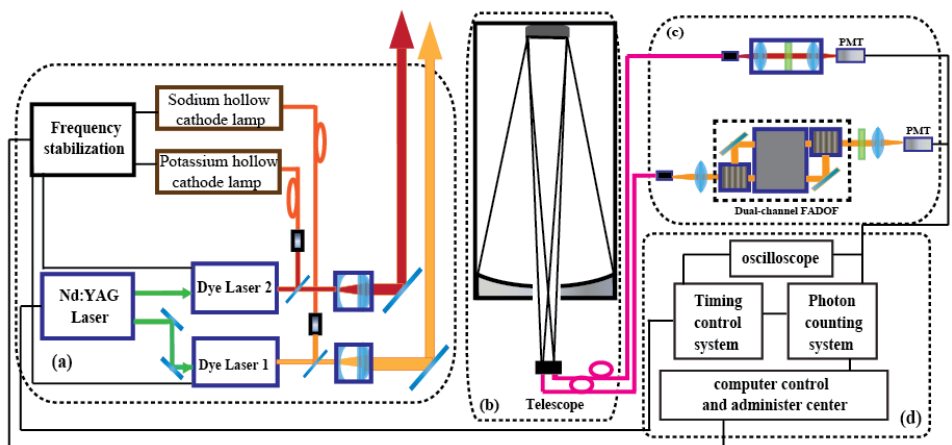
Figure 1. Schematic diagram of diurnal sodium fluorescence lidar system (dual-wavelength lidar detection system). A lidar system is composed of ( a ) a laser emission system, ( b ) a signal receiving system, ( c ) a signal detection system, and ( d ) a data acquisition and timely sequence control system.